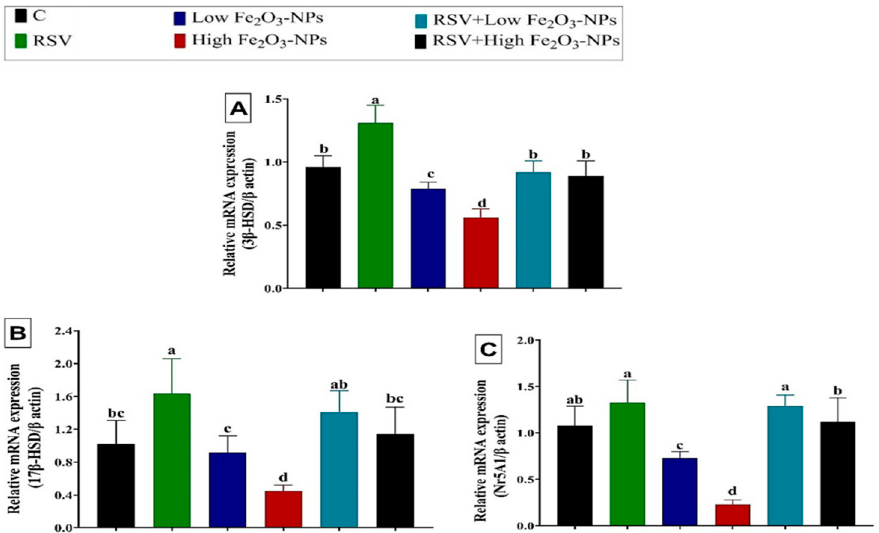
Figure 6. Effect of resveratrol (RSV; 20 mg/kg b.wt) and/or iron oxide nanoparticles (Fe 2 O 3 -NPs 3.5 or 7 mg/kg b.wt) administration for eight weeks on mRNA expression of ( A ) 3 beta-Hydroxysteroid dehydrogenase ( 3 β -HSD ), ( B ) 17-beta hydroxysteroid dehydrogenase ( 17 β -HSD ), and ( C ) Nuclear Receptor Subfamily 5 Group A Member 1 ( Nr5A1 ) in the testicular tissues of male rats. Data expressed as mean ± SD, n = 9 for each group. Different letters (a, b, c, and d) on columns indicate statistically significant differences at p < 0.05 between the different experimental groups.